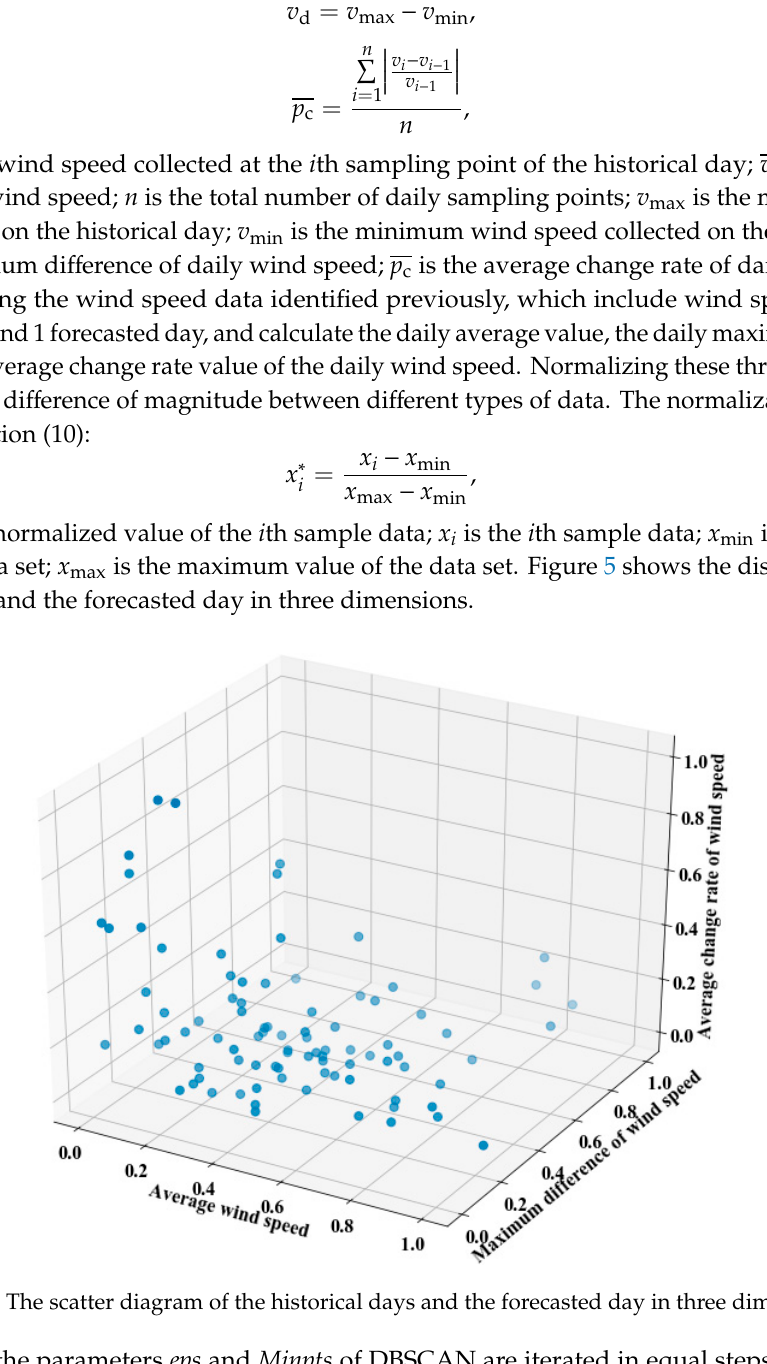
Figure 6. The scatter diagram of the historical days and the forecasted day in three dimensions. The number of the similar days obtained by DBSCAN algorithm is 53, which still needs to be further screened to improve the efficiency and accuracy of the prediction model. The Euclidean distances can be calculated as Equation (11) [15]: = =